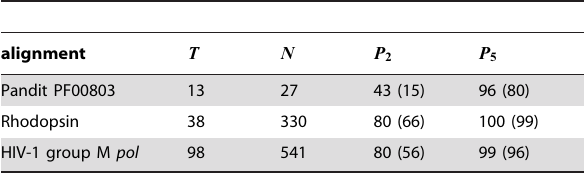
Table 1. Comparison of single rate versus random models for 3